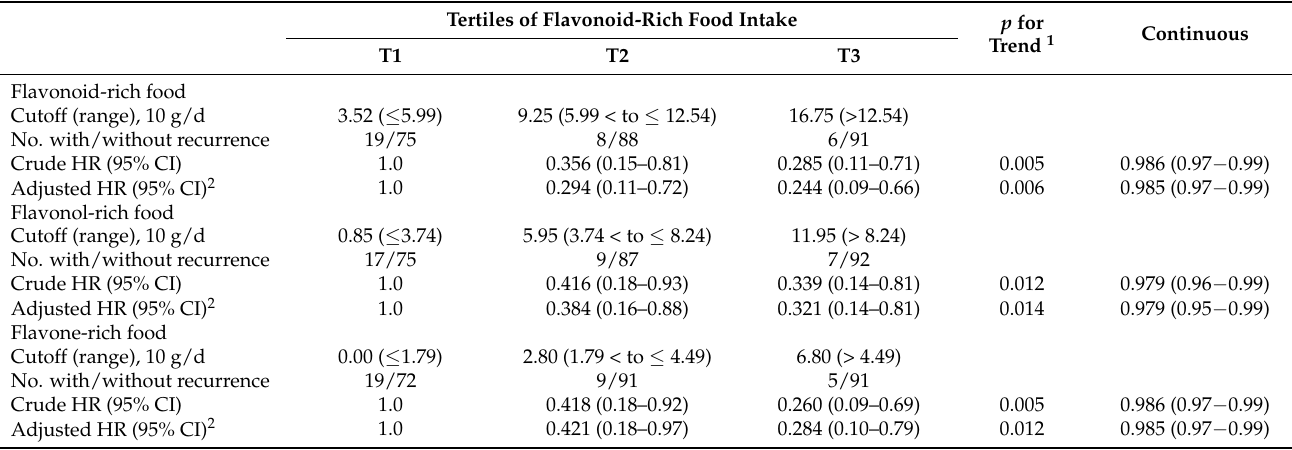
1 Estimates of p -values for linear trends were based on linear scores derived from the medians of tertiles of flavonoid-rich food intake in overweight and obese patients; 2 adjusted hazard ratios (HRs) and 95% confidence intervals (CIs) were analyzed using Cox proportional hazards regression analysis after adjusting for age, waist circumference, alcohol drinking, tumor size, lymph node metastasis, histological grade, and energy